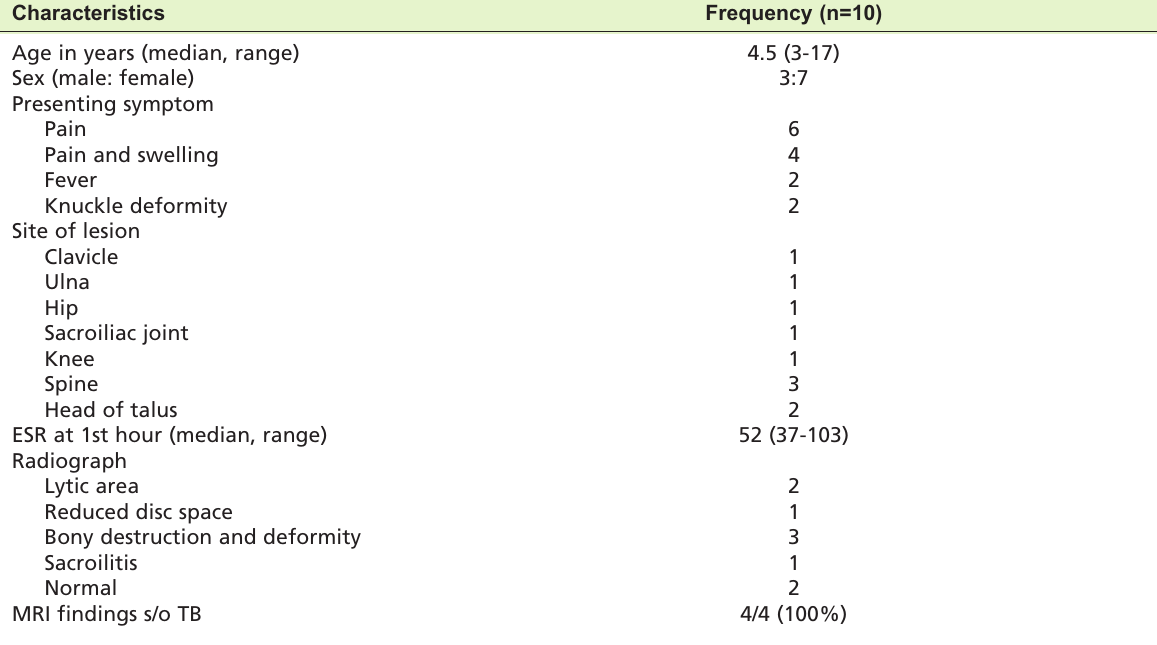
Characteristics of children suspected with OA Table II: